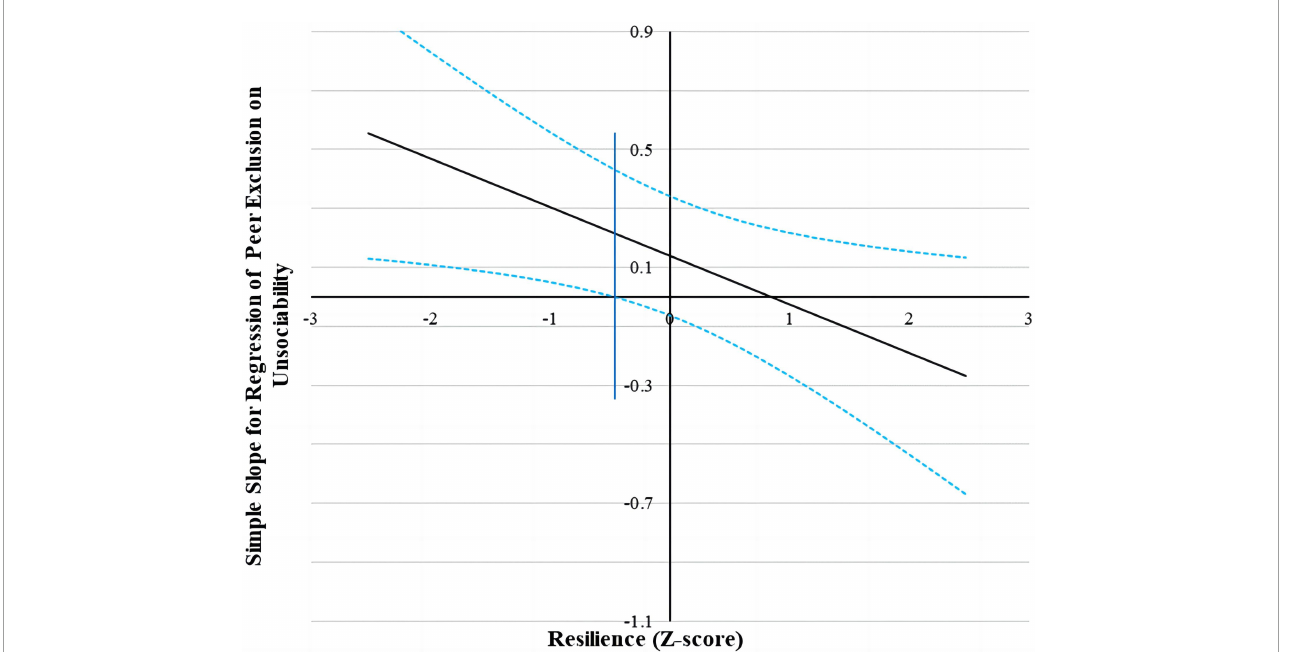
FIGURE2 Johnson–Neyman regions of significance and confidence bands for mother-rated unsociability along resilience in relation to peer exclusion. Solid diagonal line represents the regression coefficient for unsociability along resilience. Dashed diagonal blue lines are confidence bands–upper and lower bounds of 95% confidence interval for unsociability regression coefficient along resilience. The vertical blue line indicates the point along resilience at which the unsociability regression coefficient transitions from statistical significance (left of dashed vertical line) to non-significance (right of dashed vertical line). The value of the dashed vertical line is − 0.46.